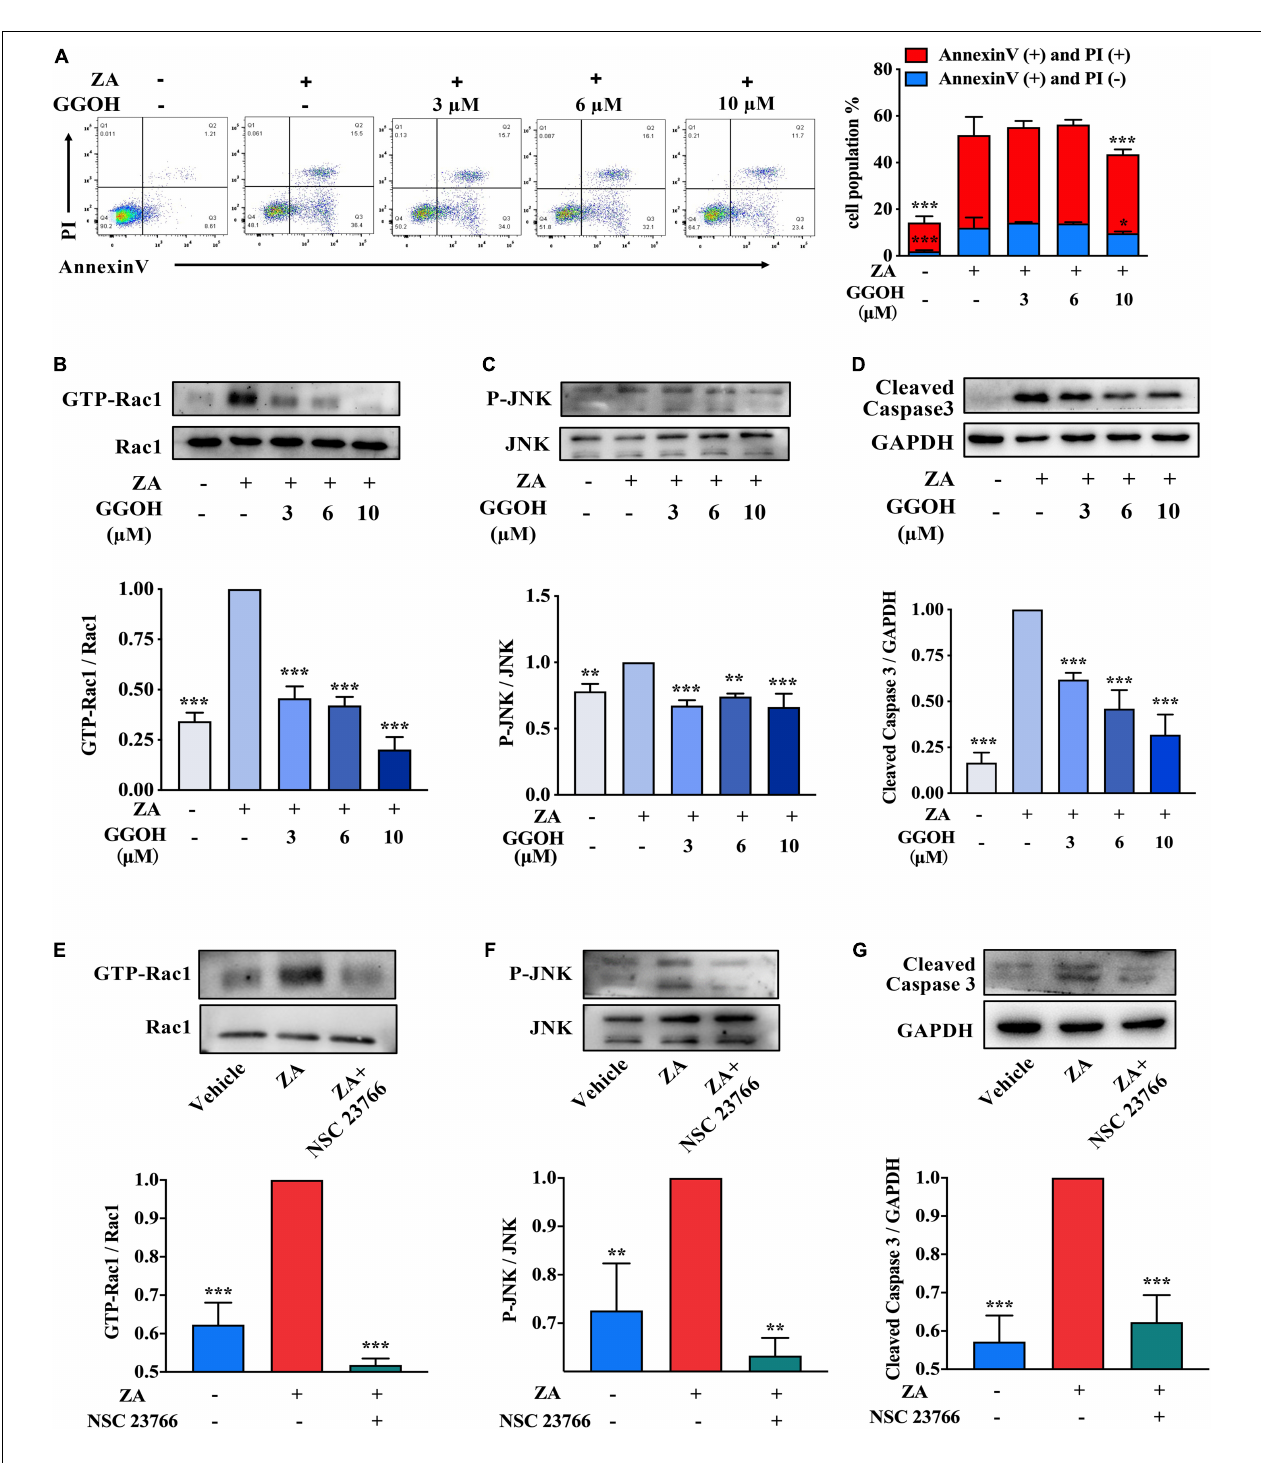
FIGURE 3 | GGOH could reduce ZA-induced apoptosis of MC3T3-E1 via inhibiting Rac1 overactivation. (A) MC3T3-E1 were cultured with ZA (10 µ M) in the presence or absence of GGOH (0–10 µ M) for 24 h. Cells were stained with Annexin V and PI and subjected to flow cytometry. Comparison of apoptosis was performed with ZA group. (B–D) MC3T3-E1 were cultured with ZA (10 µ M) in the presence or absence of GGOH (0–10 µ M) for 24 h. The expression levels of active Rac1 (GTP-Rac1), active JNK (P-JNK), and cleaved caspase 3 were measured by Western blotting. (E–G) MC3T3-E1 were cultured with a vehicle, ZA (10 µ M) in the presence or absence of NSC 23766. The expression levels of active Rac1 (GTP-Rac1), active JNK (P-JNK), and cleaved caspase 3 were measured by Western blotting. The data are presented as the mean ± SEM values ( n = 3). * p < 0.05, ** p < 0.01, *** p < 0.001. GGOH, geranylgeraniol; ZA, zoledronic acid; PI, propidium